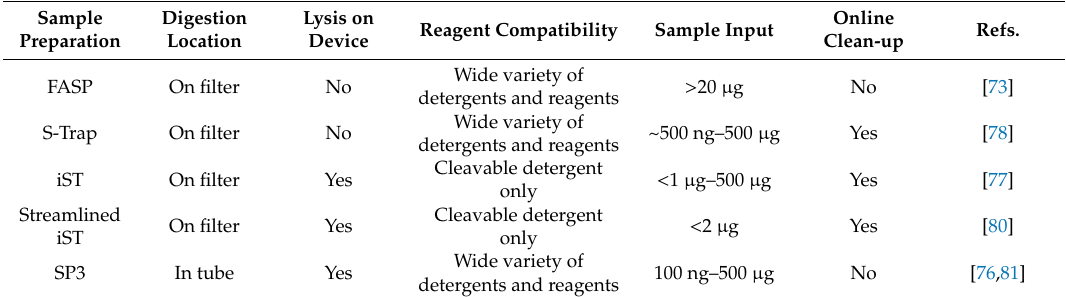
Table 1. Comparison of modern sample preparation approaches for e ffi cient bottom-up